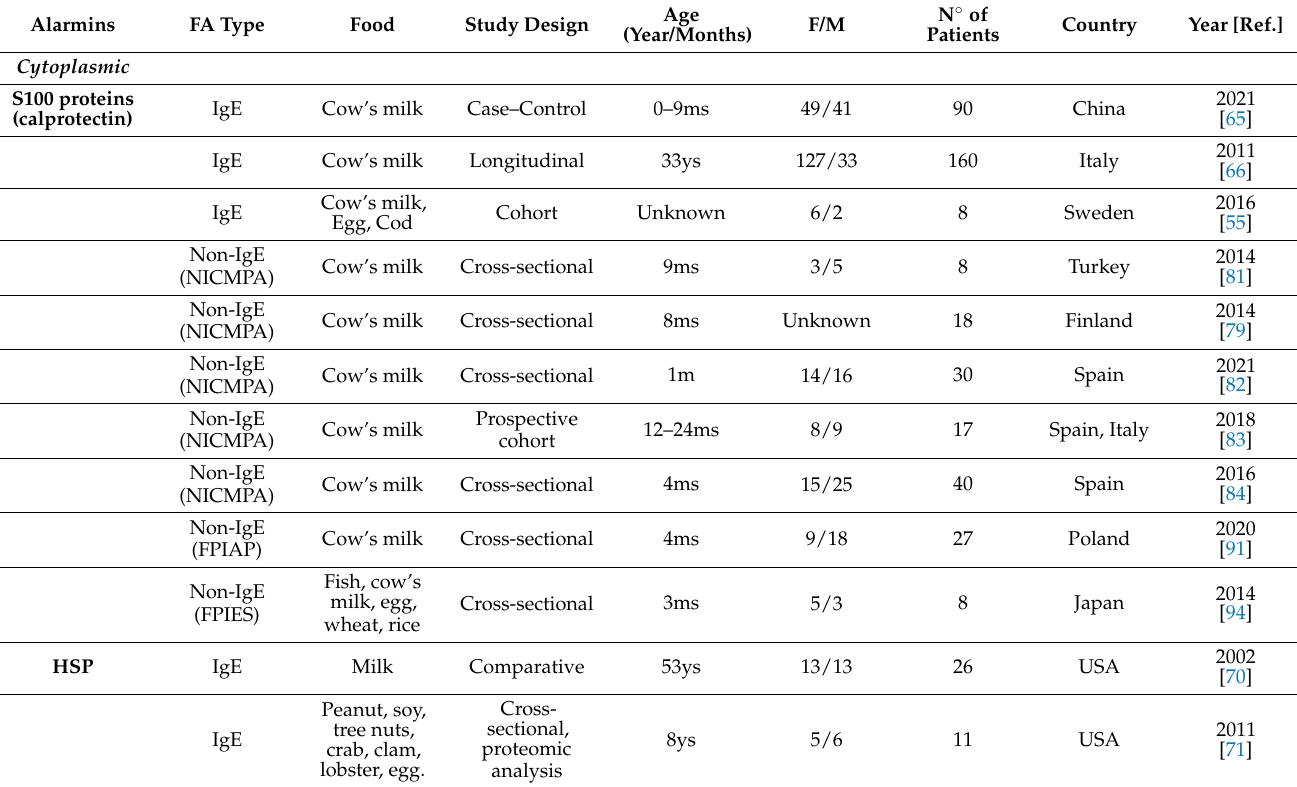
Table 3. Human studies on cytoplasmic alarmins in food